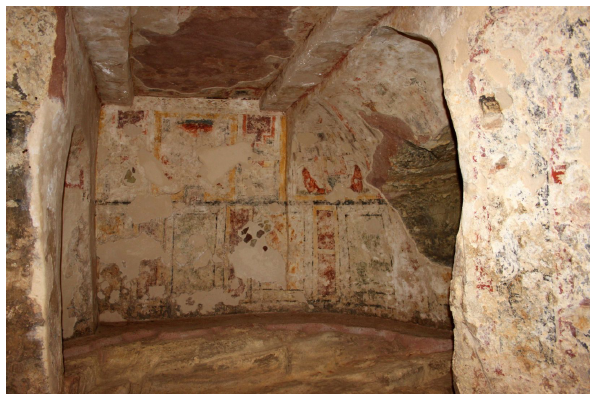
Figure 4. Wall paintings